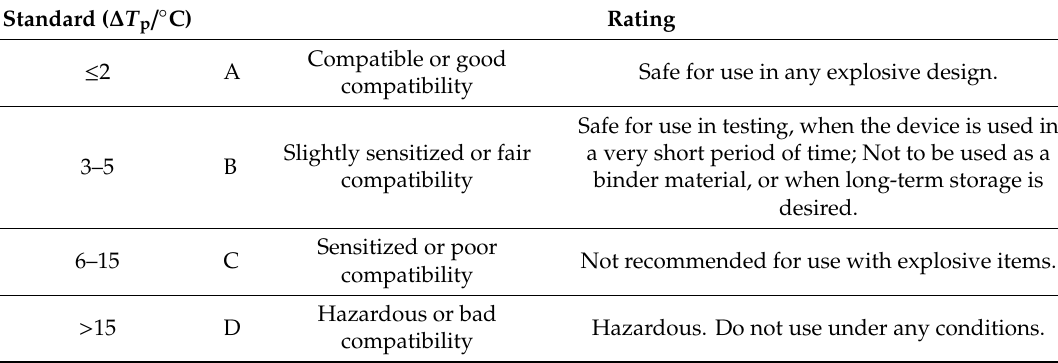
Figure 7. DSC curves for complex 1 ( a ), complex 1 and HMX ( b ), and pure HMX ( c ). Table 2. Evaluated criterion of compatibility for explosives and energetic materials